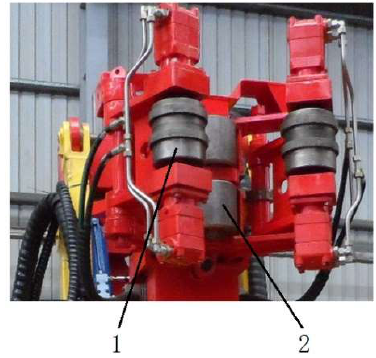
Figure 6. Single follow-up roller installed on the wedge plate. In the figure: 1—roller, 2—wedge plate.